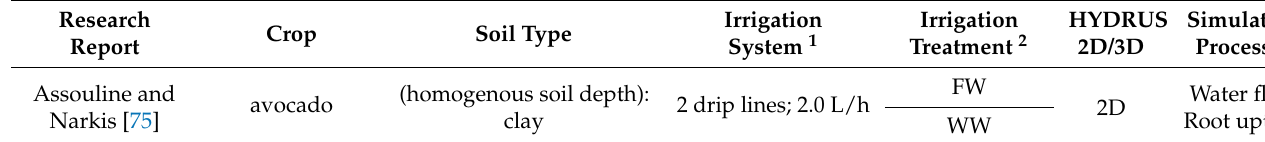
Table 3. Summary of HYDRUS 2D/3D simulations in avocado